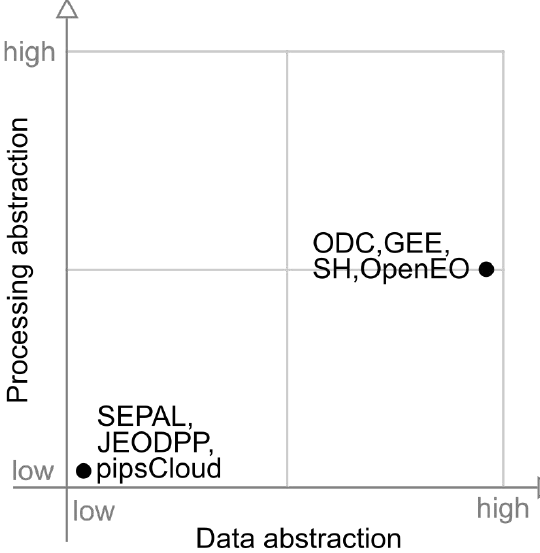
Figure 8. Data abstraction vs. Processing